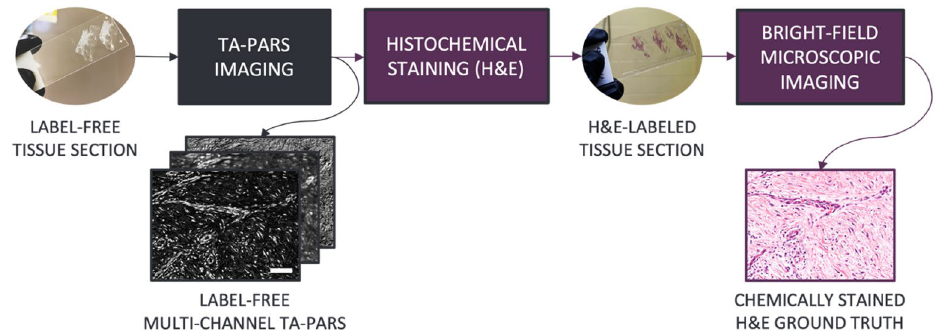
Figure 1. TA-PARS and H&E dataset preparation process of human skin tissue slide images. Scale bar: 50 µm.